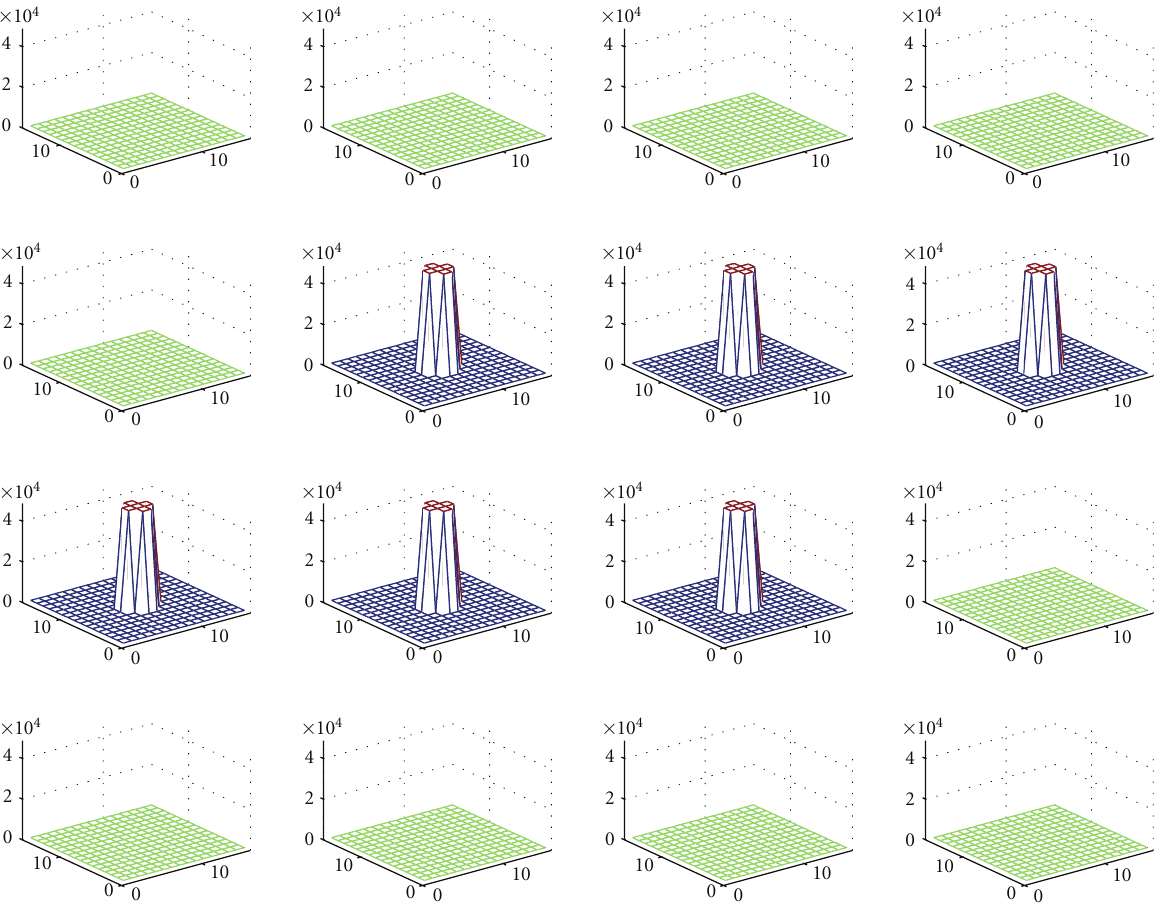
Figure 7: Original object (cylinder) in a cube consisting of 16 transaxial planes (reprinted with permission from